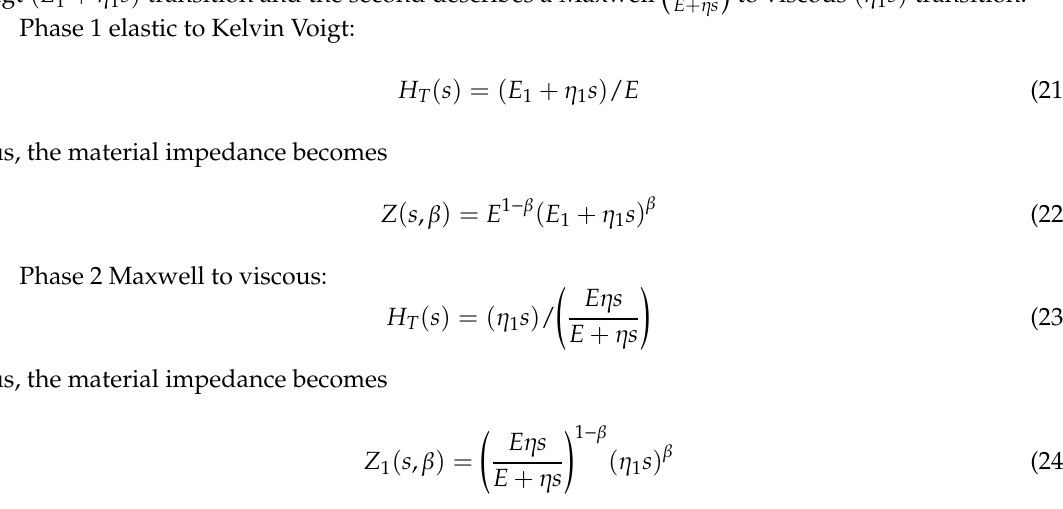
- - - - - - , 72 ° C , - - - - , 72 ° C , , 72 ° C , , 72 ° C , , 72 ° C ,